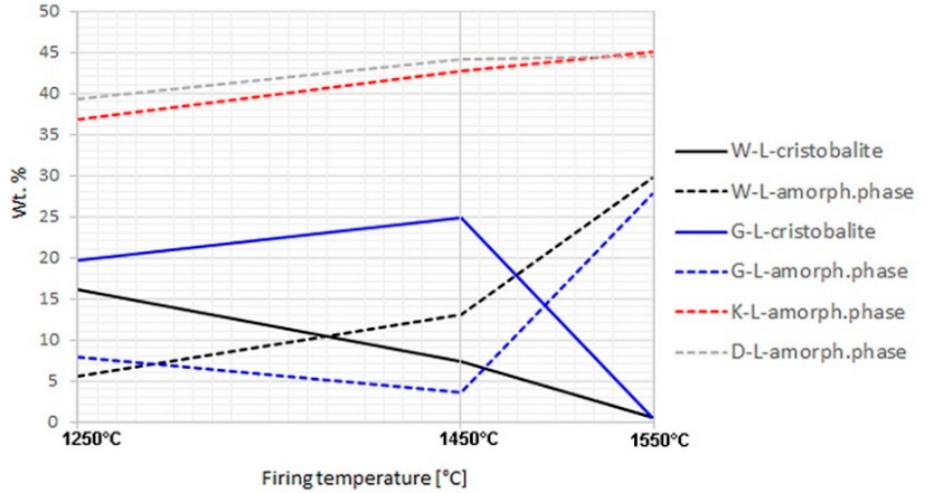
Figure 1. Cristobalite and amorphous phase contents in laboratory-fired samples; no cristobalite was detected in K-L and D-L samples.